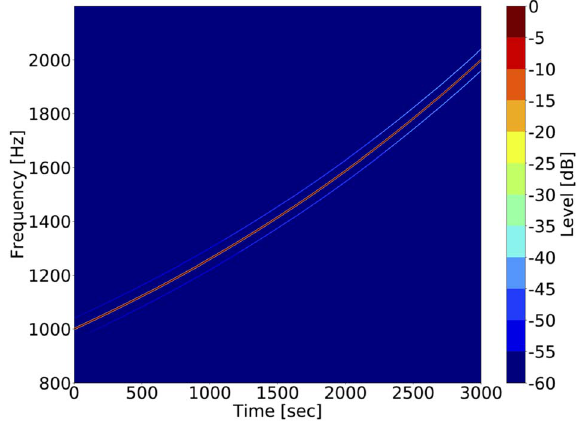
Figure 13. Spectrogram of the acoustic pressure p ð z ¼ 1 ; t Þ for a corrected diaphragm displacement n distortion is reduced compared to Figure